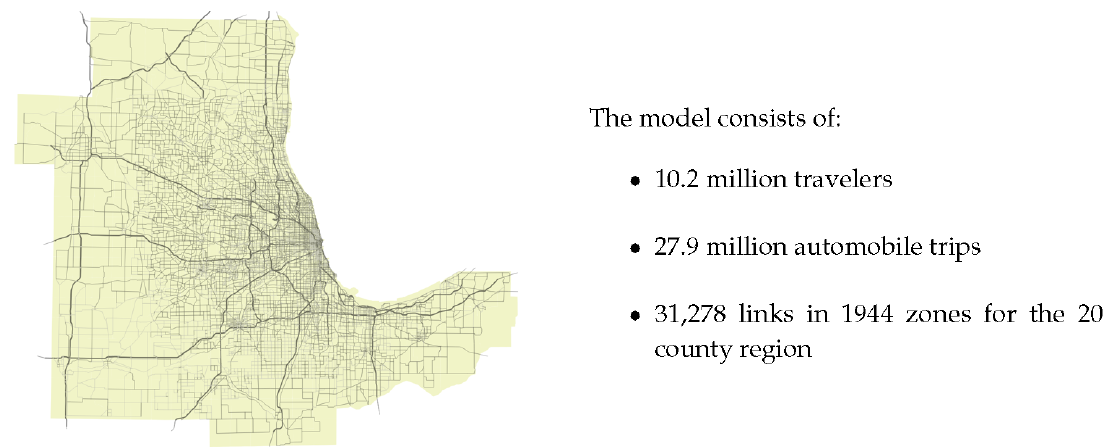
Figure 2. Chicago Metropolitan Area Road